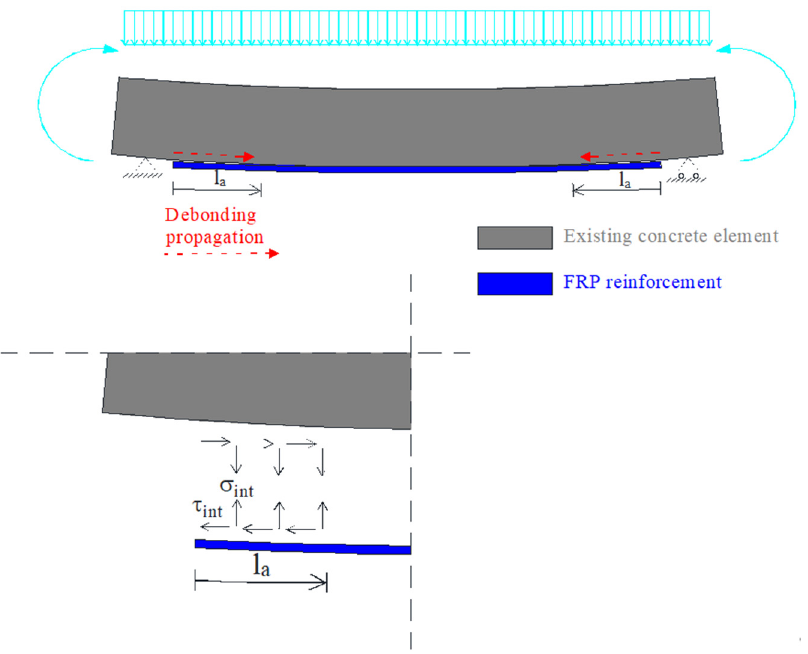
Figure 2. Cutoff cross-section